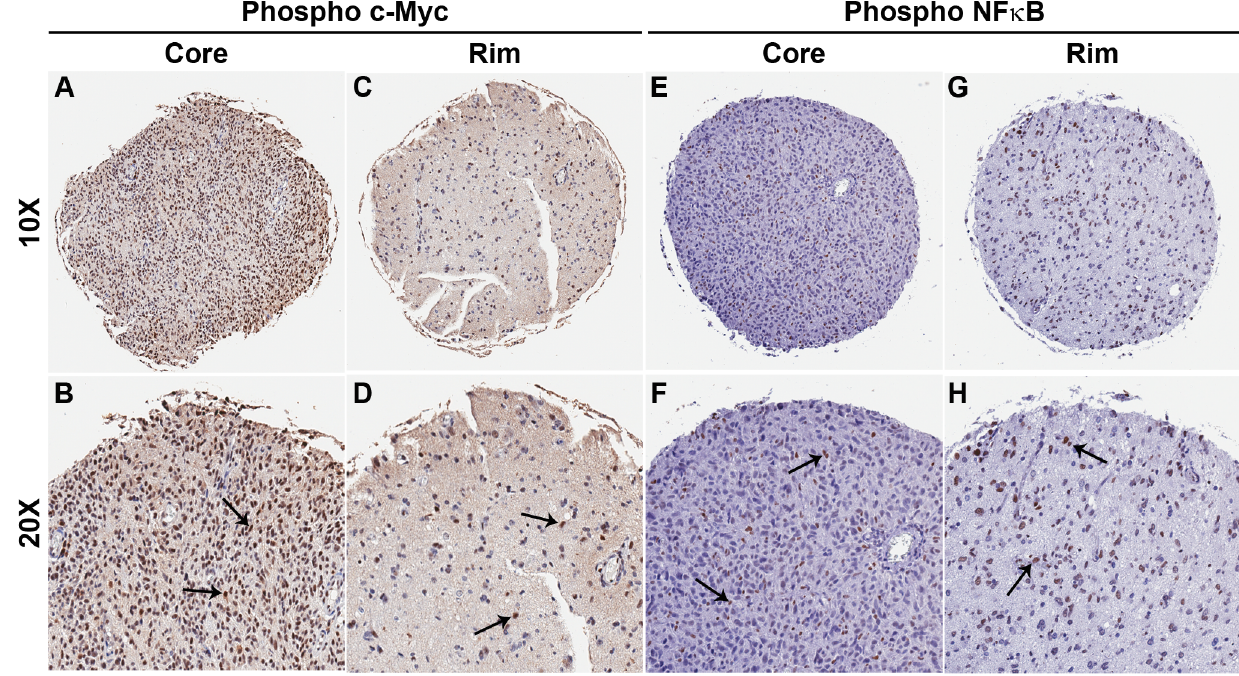
Figure 5. Glioma tumor specimens show differential activation of c-Myc and NF- k B in core and invasive rim. Immunohistochemistry of matched glioma core and rim sample from a glioma invasion specific tissue microarray (n=45). Phosphorylated c-Myc nuclear protein expression is greater at the glioma tumor core than the rim regions of tumor. Representative 10X images of core (A) and rim (C) of a GBM sample. 20X images of core (B) and rim (D) of the same GBM sample. Phosphorylated NF k B nuclear protein expression is greater at the glioma tumor rim than the core regions of tumor. Representative 10X images of core (E) and rim (G) of a GBM sample. 20X images of core (F) and rim (H) of the same GBM sample. Black arrows represent positively stained nuclear regions of the glioma tumor cells.